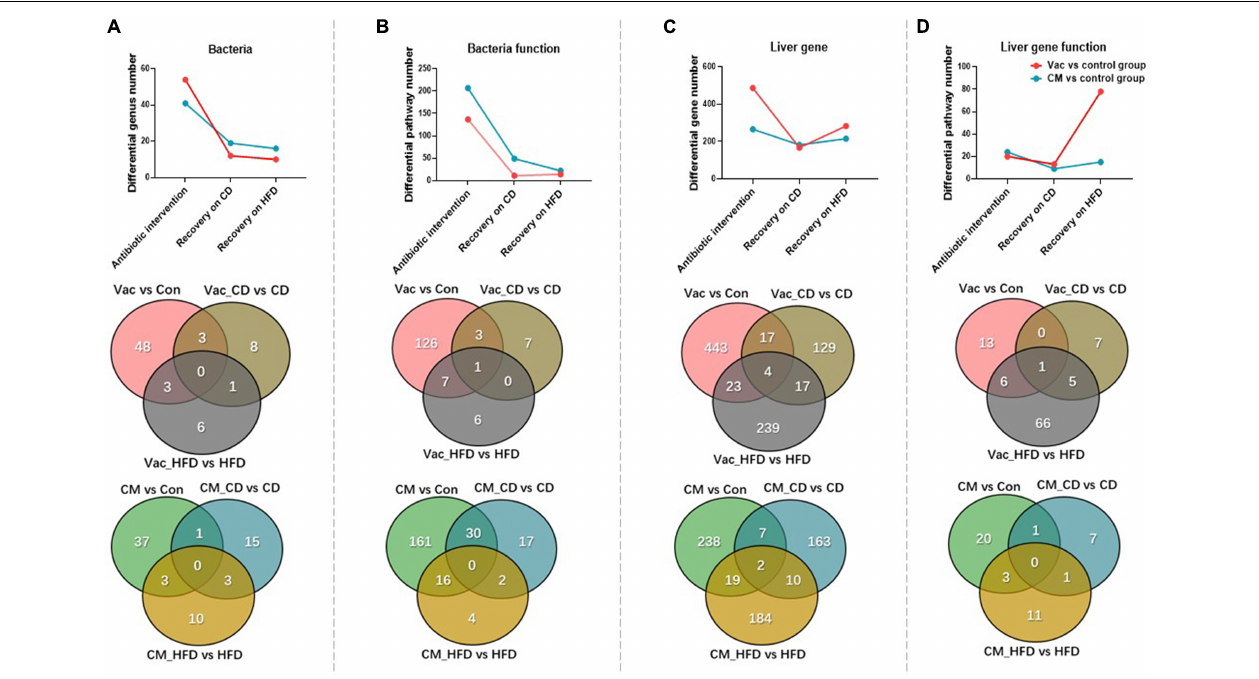
FIGURE 7 | The changes of gut microbiota and liver gene after antibiotic intervention and post-antibiotic recovery. (A–D) Venn diagram and line chart show the number changes of differential genus, functional prediction of bacteria at KEGG pathway level 3, differential expression of liver genes, and functional prediction of genes among the three conditions under the same screening